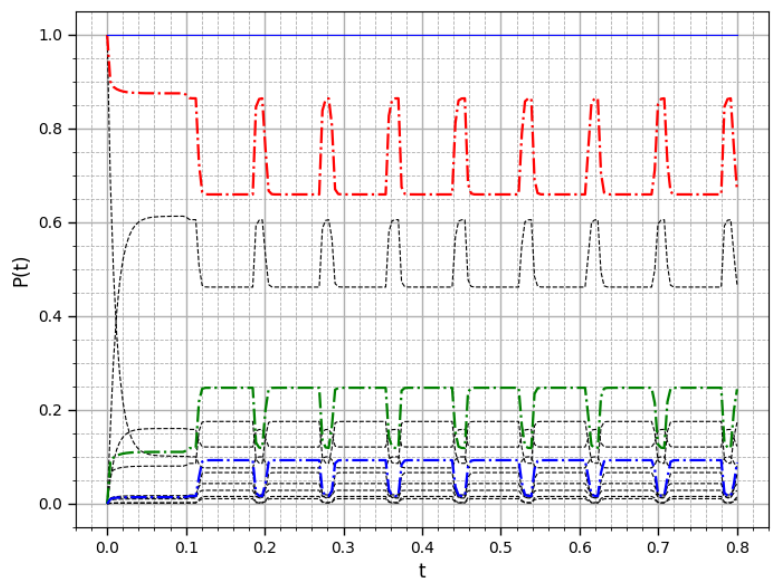
Figure 7. Dependencies of the probabilities of states with a periodic abrupt change in the arrival intensity ( λ 1 = 10 packets/s, λ 2 = 200 packets/s, t 1 = 0.015 s, t 2 = 0.07 s).